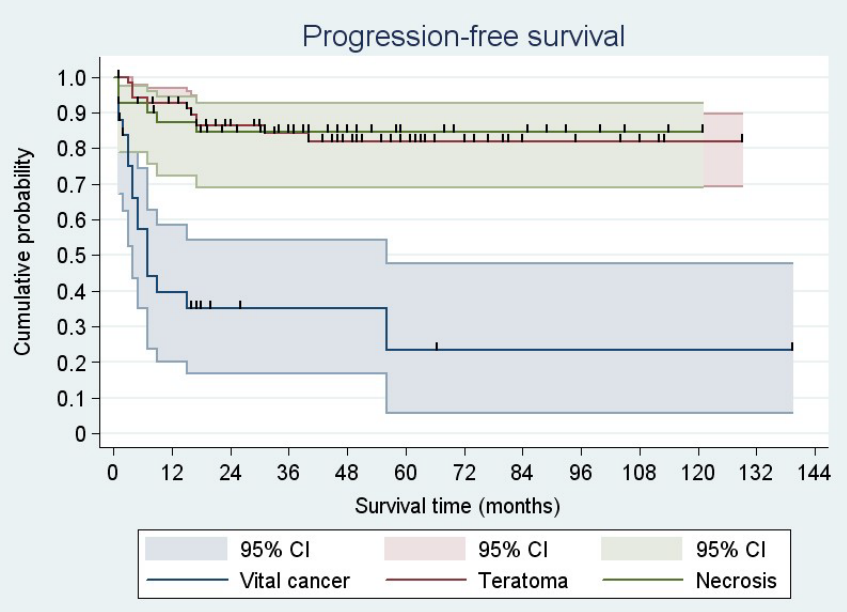
Kaplan-Meier analysis of progression-free survival after stratification for histology in the resected specimen. Vital cancer progression-free survival at 5 years 23% (95% CI: 6–48%) Teratoma progression-free survival at 5 years 82% (95% CI: 69–90%) vital